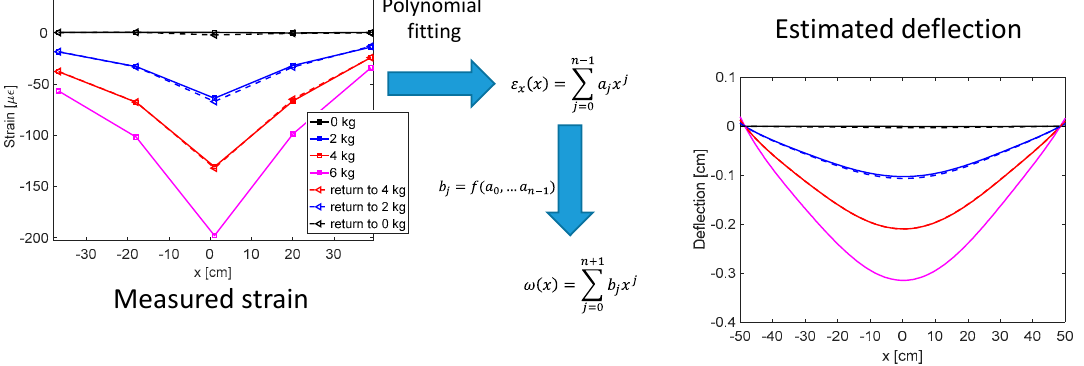
Figure 3. Procedure to obtain the polynomial deflection function of a